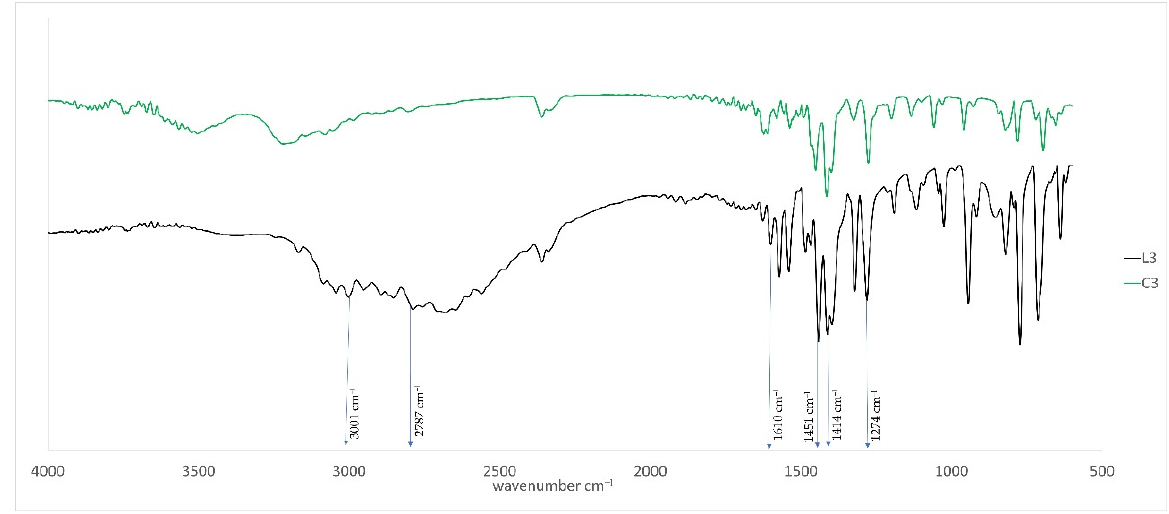
Figure 3. FTIR spectrum of free organic ligands L3 and complex C3.